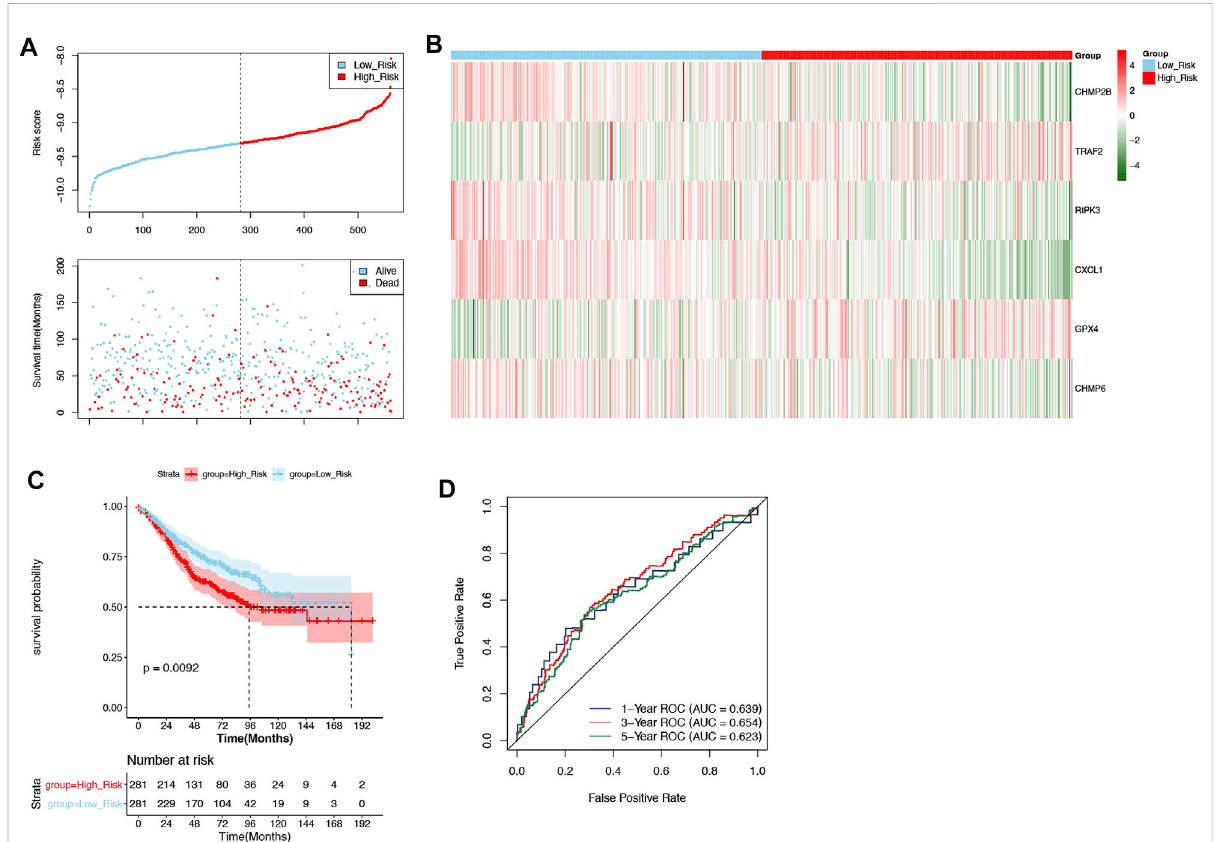
FIGURE 4 Validation of the prognostic signature in the validation set. (A) The patients in the GSE39582 dataset were categorized into high-risk and low- risk groups. (B) The expression of 6 DENRGs in high-risk and low-risk groups. (C) The Kaplan – Meier curve of high-risk and low-risk groups. (D) The ROC curve was used to assess the validity of the prognostic